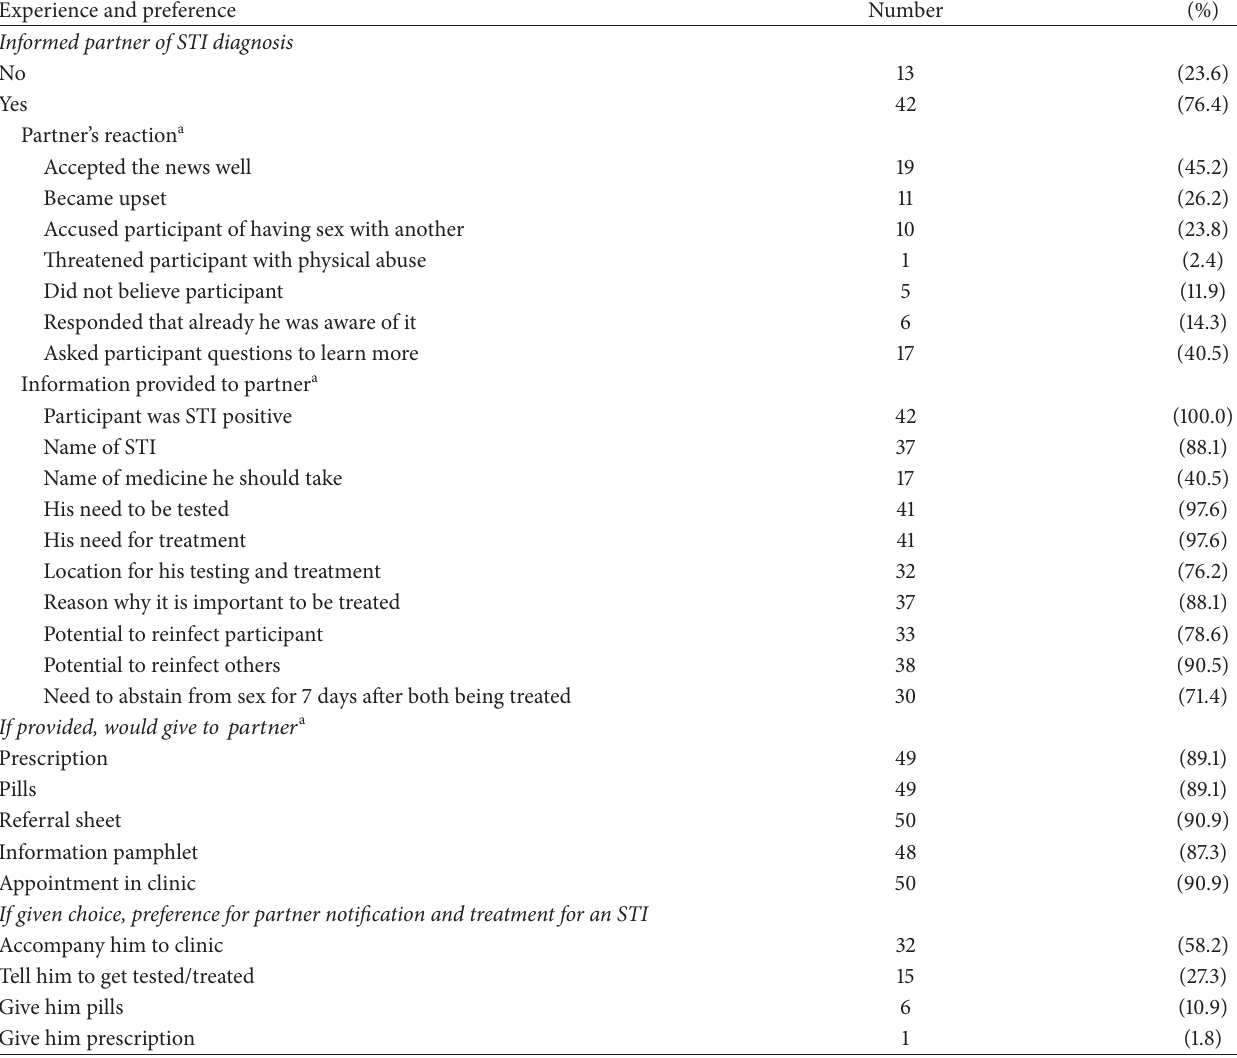
Table 4: Experiences and preferences for partner notification, follow-up study ( 𝑁 =